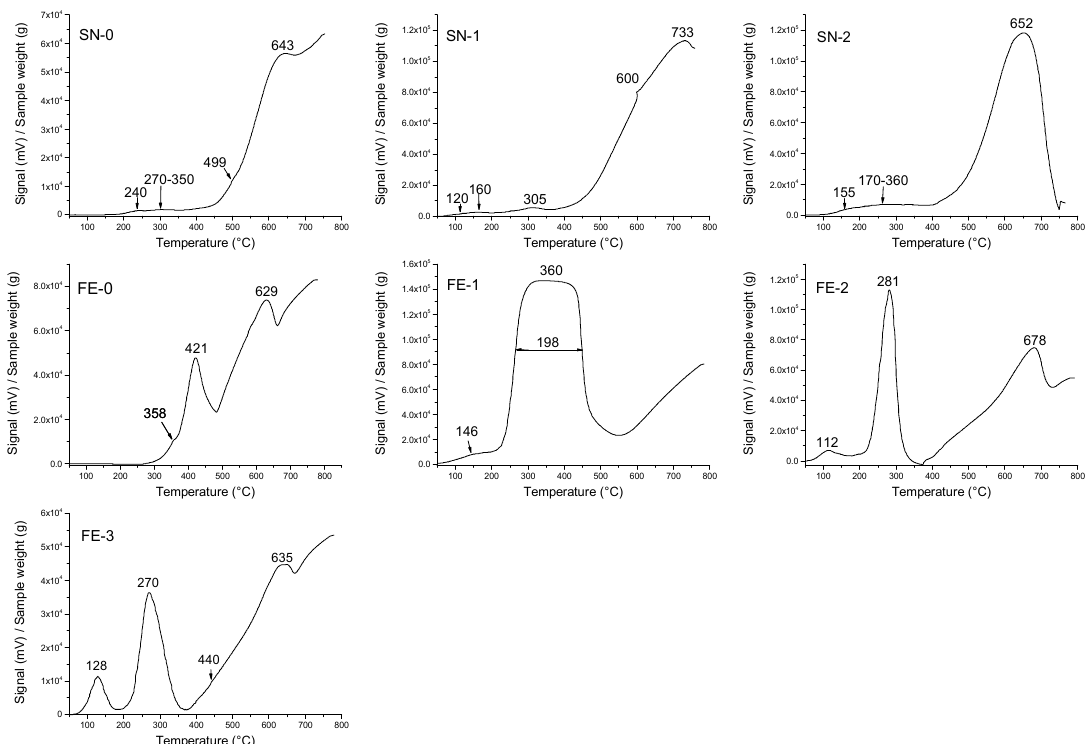
the two-step platinum doping, the Pt 4+ → Pt 0 reduction maxima are well defined and distinct at 112 and 128 ◦ C for samples FE-2 and FE-3, respectively. In the pristine α -Fe 2 O 3 (sample FE-0) and α -SnO 2 (sample SN-0) there is no platinum, and consequently, there is no reduction maxima below 200 ◦ C.